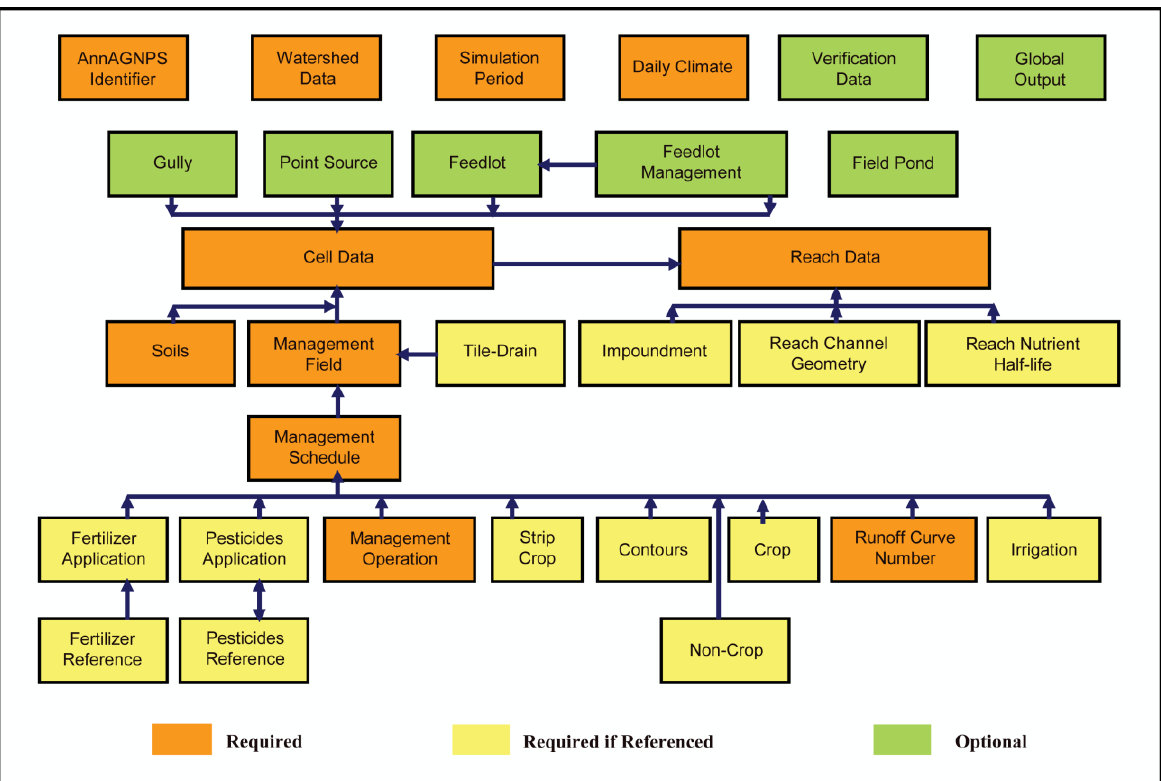
Figure 1. AnnAGNPS input data